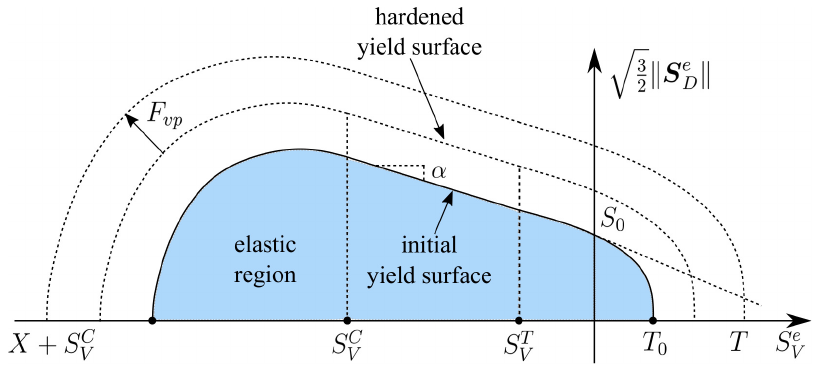
Figure 2. Effect of rate dependency to the yield